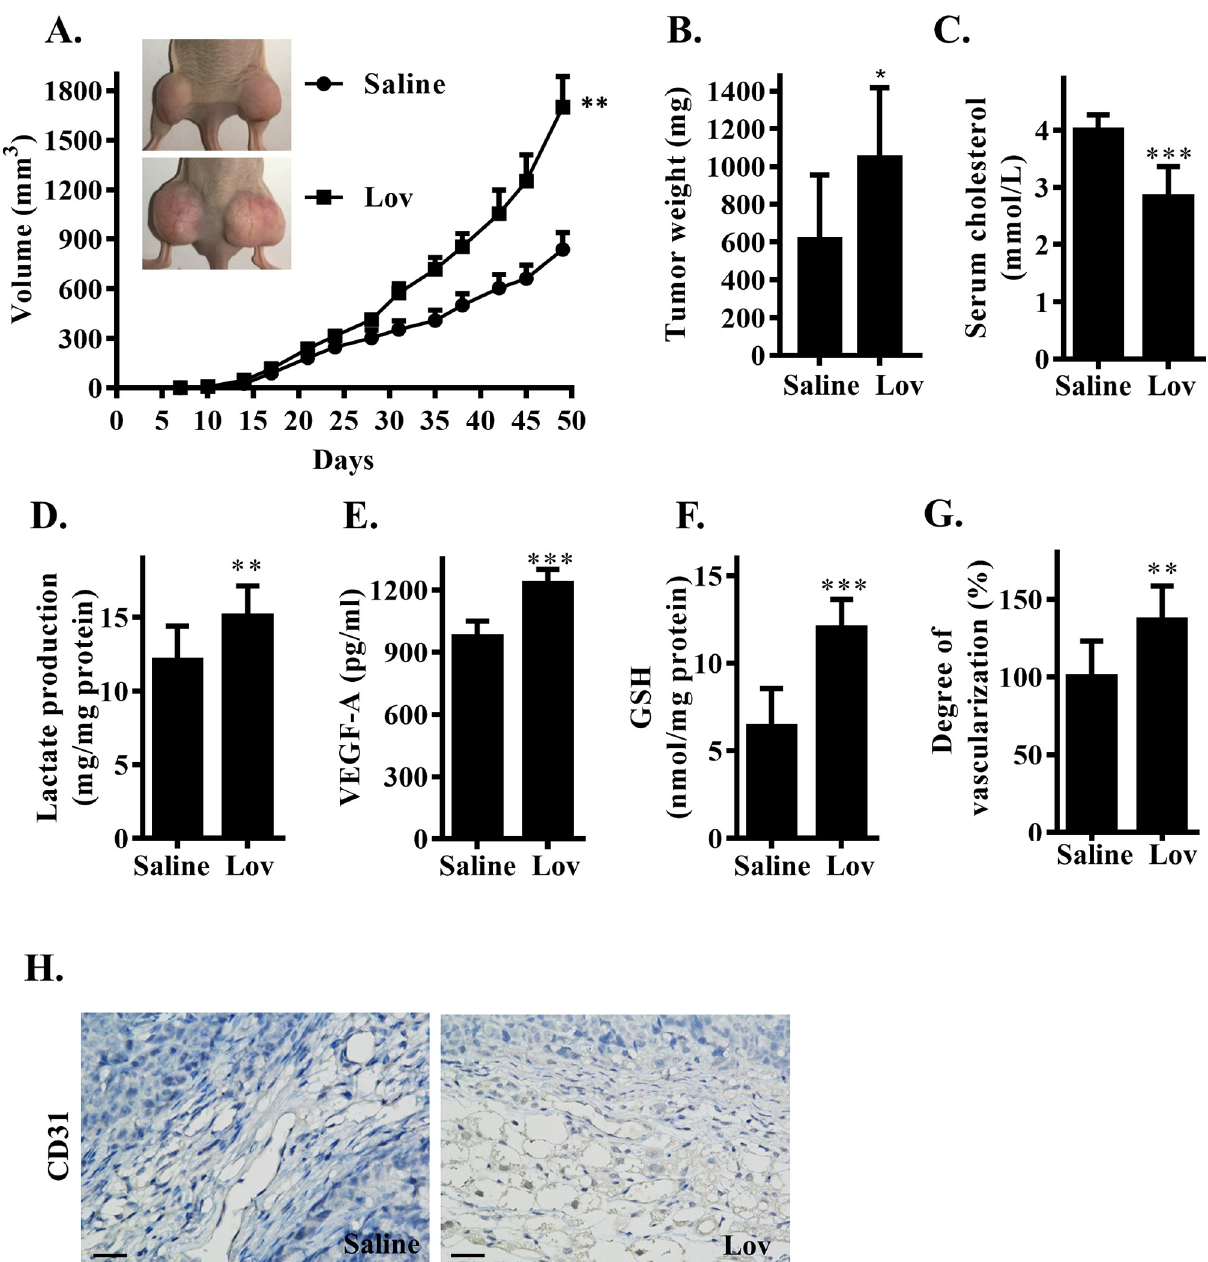
Fig 1. Inhibition of HMGCR promoted RCC tumor growth. (A) Tumor diameters of lovastatin-treated xenograft mice. ACHN cells were injected into bilateral flank of mice. Healthy control group were treated with saline and lovastatin-treated group were oral administered with lovastatin (Lov) at a dose of 5 mg/kg 2 days after modeling. (B) Xenograft tumors were resected and weighed after mice were killed on day 49. (C) Serum cholesterol levels on day 49 ( n = 10 each group) after last treatment. (D) Lactate, (E) VEGF, and (F) GSH level in resected tumor. (G) Xenografts neovascularization were measured by the Drabkin’s reagent kit. (H) Immunohistochemical staining of CD31 in ACHN xenografts (scale bar: 50 μ m). Data are shown as mean ± SD, � ( p � 0.05), �� ( p � 0.01), or ��� ( p � 0.001). GSH, glutathione; HMGCR, 3-hydroxy-3-methylglutaryl coenzyme A reductase; Lov, lovastatin; RCC, renal cell carcinoma; VEGF, vascular endothelial growth factor.